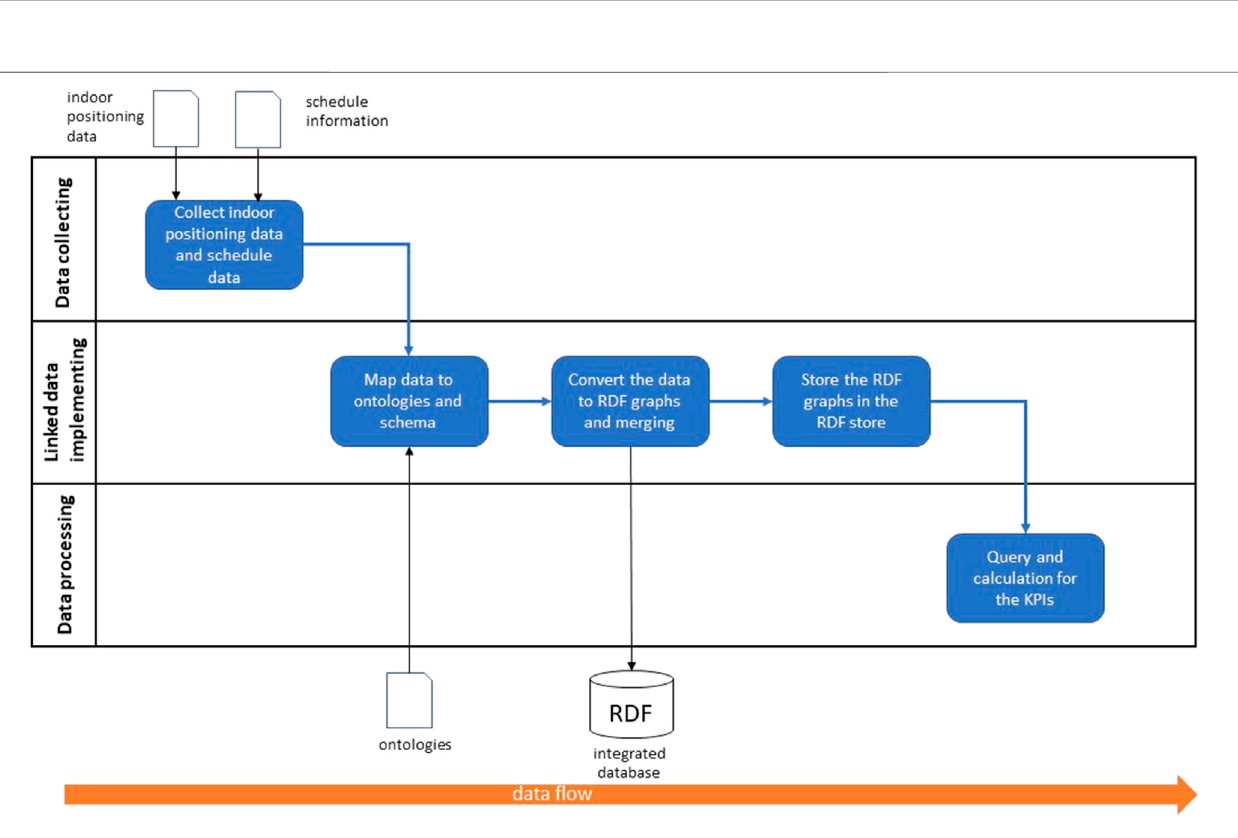
FIGURE 3 | Architecture of the linked data